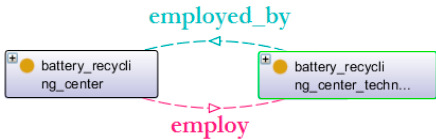
Figure 11. Object properties of the actor environment.